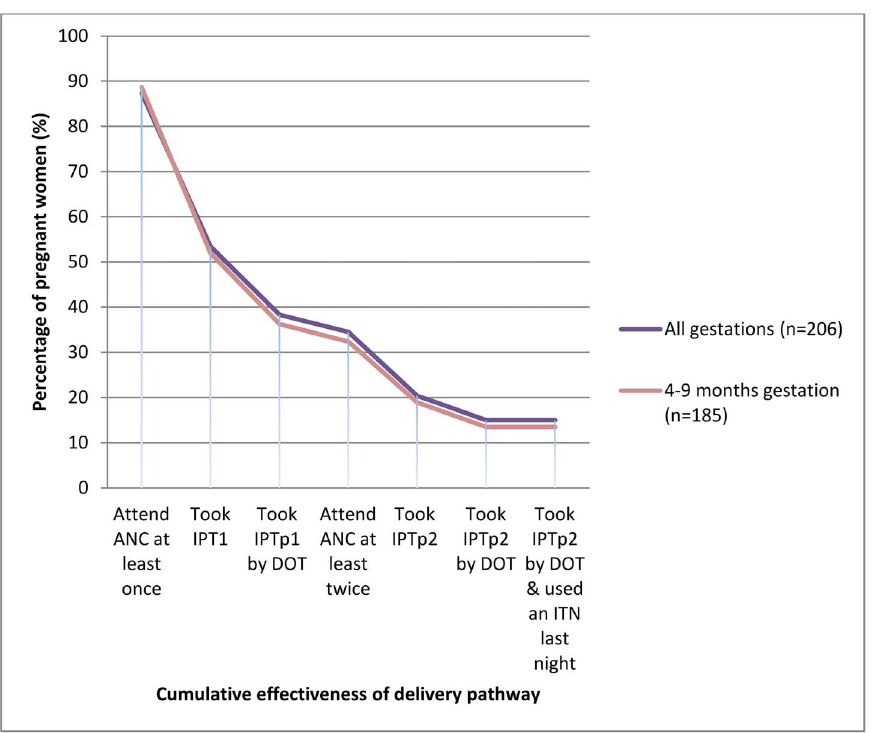
Figure 5. Cumulative effectiveness of ANC to deliver IPTp and ITNs among recently pregnant women.